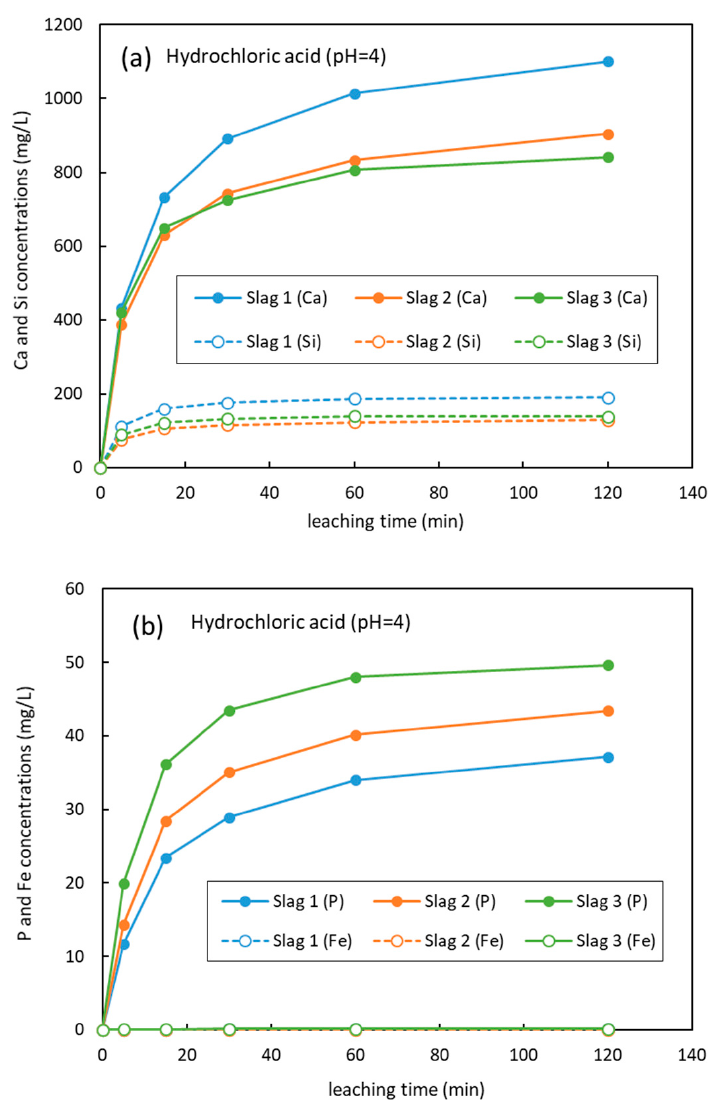
Figure 2. ( a ) Change in the Ca and Si concentrations with time in the hydrochloric acid solution; ( b ) Change in the P and Fe concentrations with time in the hydrochloric acid solution.